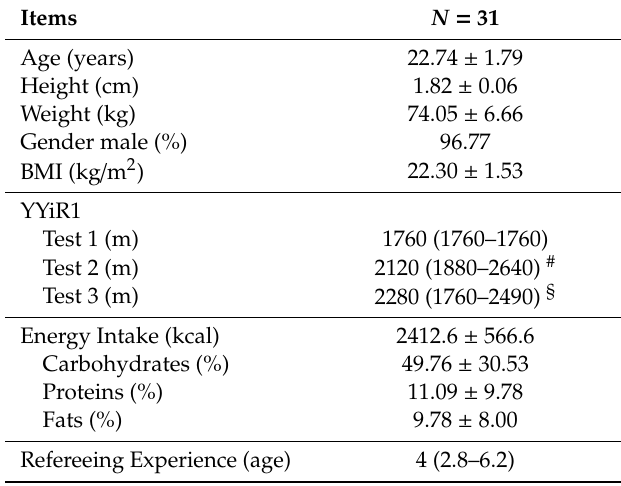
Table 1. Baseline patients’ characteristics and main results.